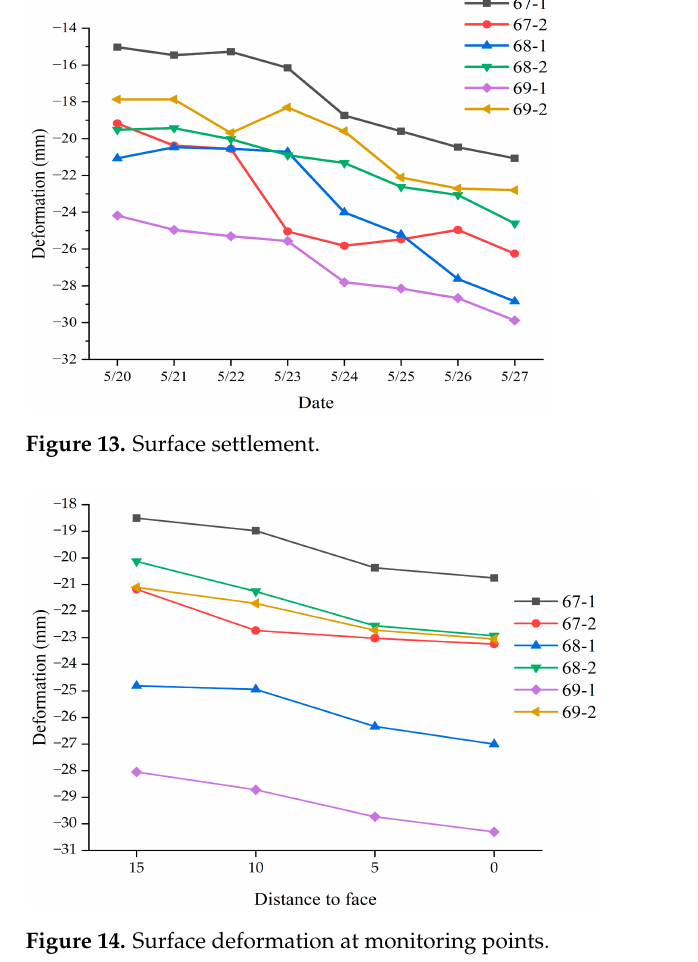
Figure 12. Distribution of monitoring points.